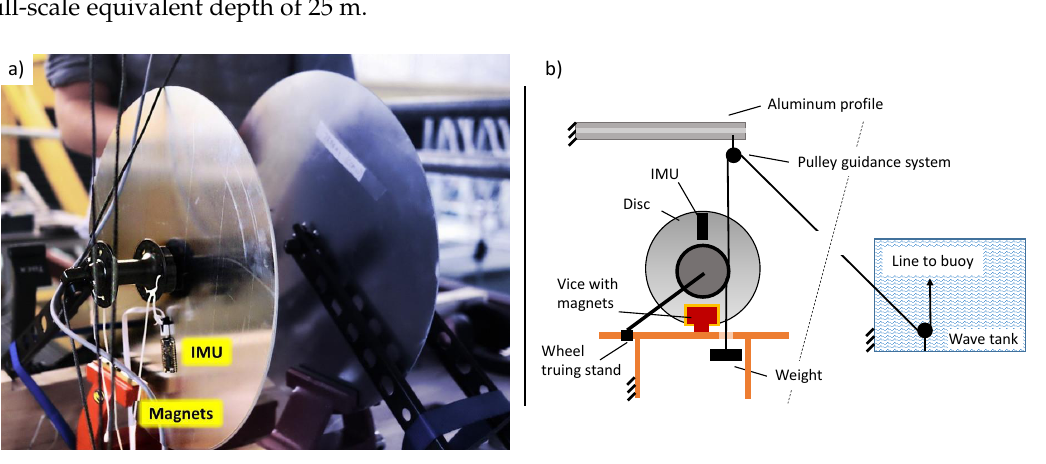
Figure 6. ( a ) Photo of the physical scale model; ( b ) Schematic of the set-up during the scale model testing in the wave